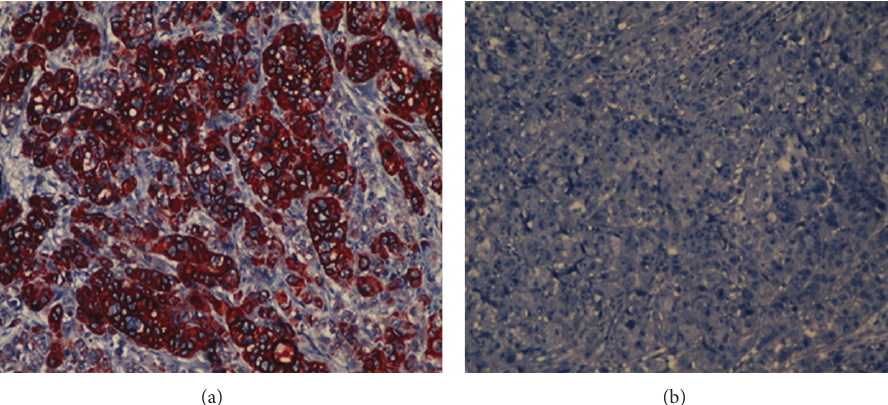
Figure 3: Immunohistochemical stainings. (a) Cytokeratin-7 staining reveals strong reactivity on the lung carcinoma. (b) Adenocarcinoma immunohistochemically negative for cytokeratin-20.